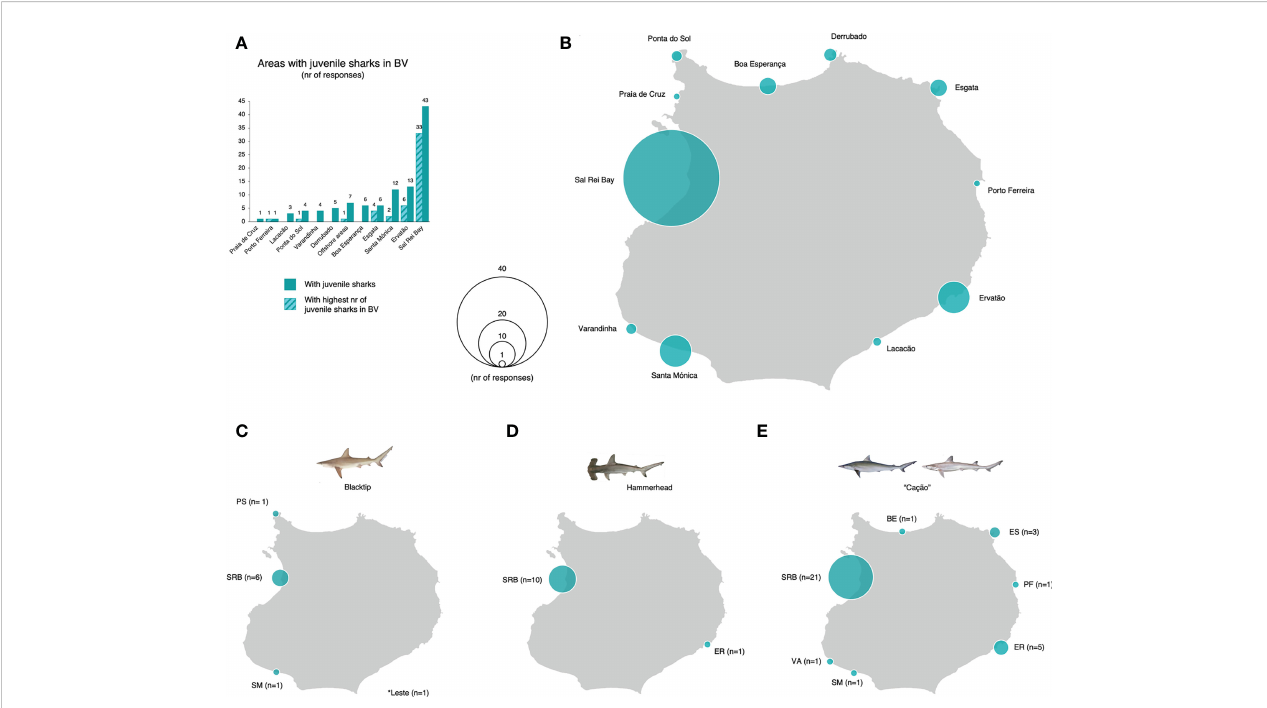
FIGURE 4 (A) Areas of occurrence of juvenile sharks in Boa Vista Island, Cabo Verde, according to local fi shermen. Eleven areas were identi fi ed based on dedicated interviews (n=55) to local registered commercial and artisanal fi shermen; six of these areas were considered as the areas with the highest number of juvenile sharks in Boa Vista Island. (B) Spatial distribution of the identi fi ed areas around the island of Boa Vista. Sal Rei Bay (SRB) collected the highest level of agreement among fi shermen, both as an area with juvenile sharks (n=43; 78%) and as the area with the highest number of juvenile sharks